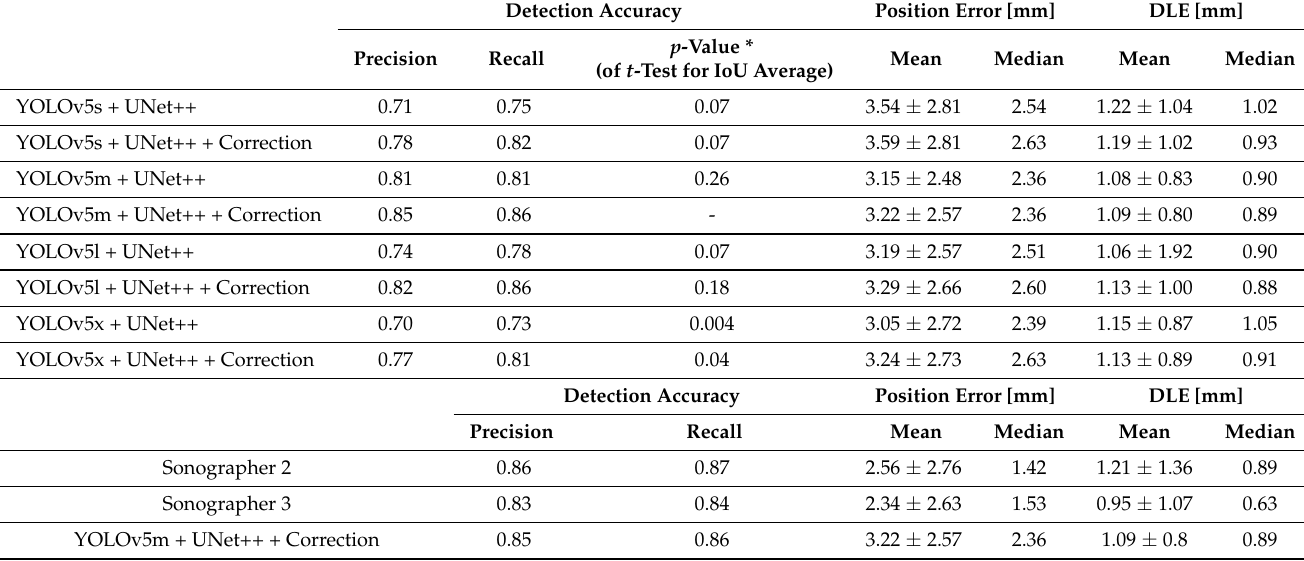
Table 3. Results of the performance of the automated system in the test data (above) and perfor- mance comparison on the 100 selected images (below) between the automated system and the two radiologists (Sonographers 2 and 3) with the annotation of two specialists (Sonographer 1 and 4) as the ground truth. The position error and DLE were calculated only for the true positive predictions of salient landmark positions. * a statistical t -test examining the average of IoU values between the “YOLOv5m + UNet++ + Correction” combination method and other combinations, along with the calculated p